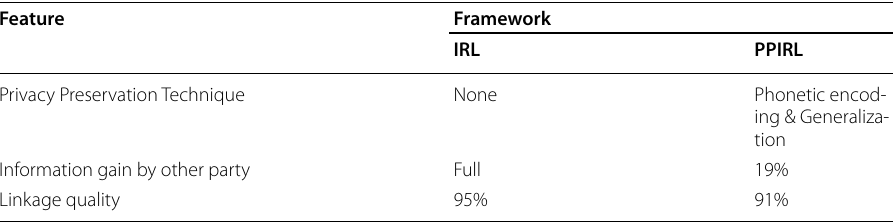
Table 9 Comparison between PPiRL and IRL